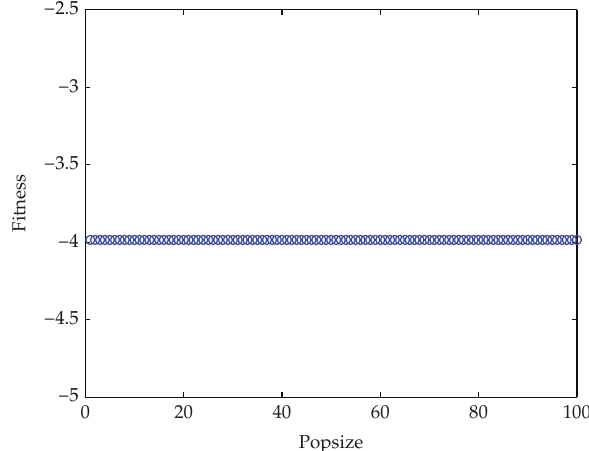
Figure 10: The final optimal function values of each individual.